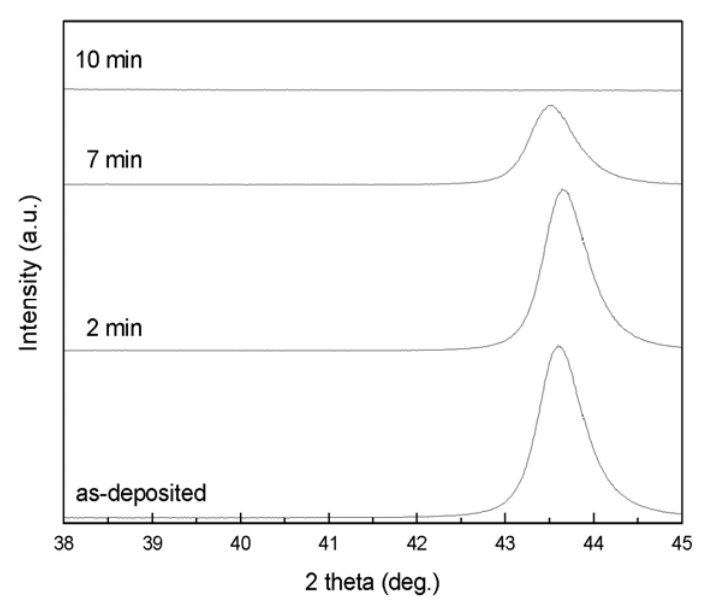
Figure 1. Evolution of dealloying in a 300 nm PdNi film immersed in concentrated (98%) sulfuric acid, as tracked by the integrated intensity of the PdNi alloy peak at ~43.6° in XRD scans. The alloy peak is still relatively strong after dealloying for 7 min, but disappears completely by 10 min dealloying